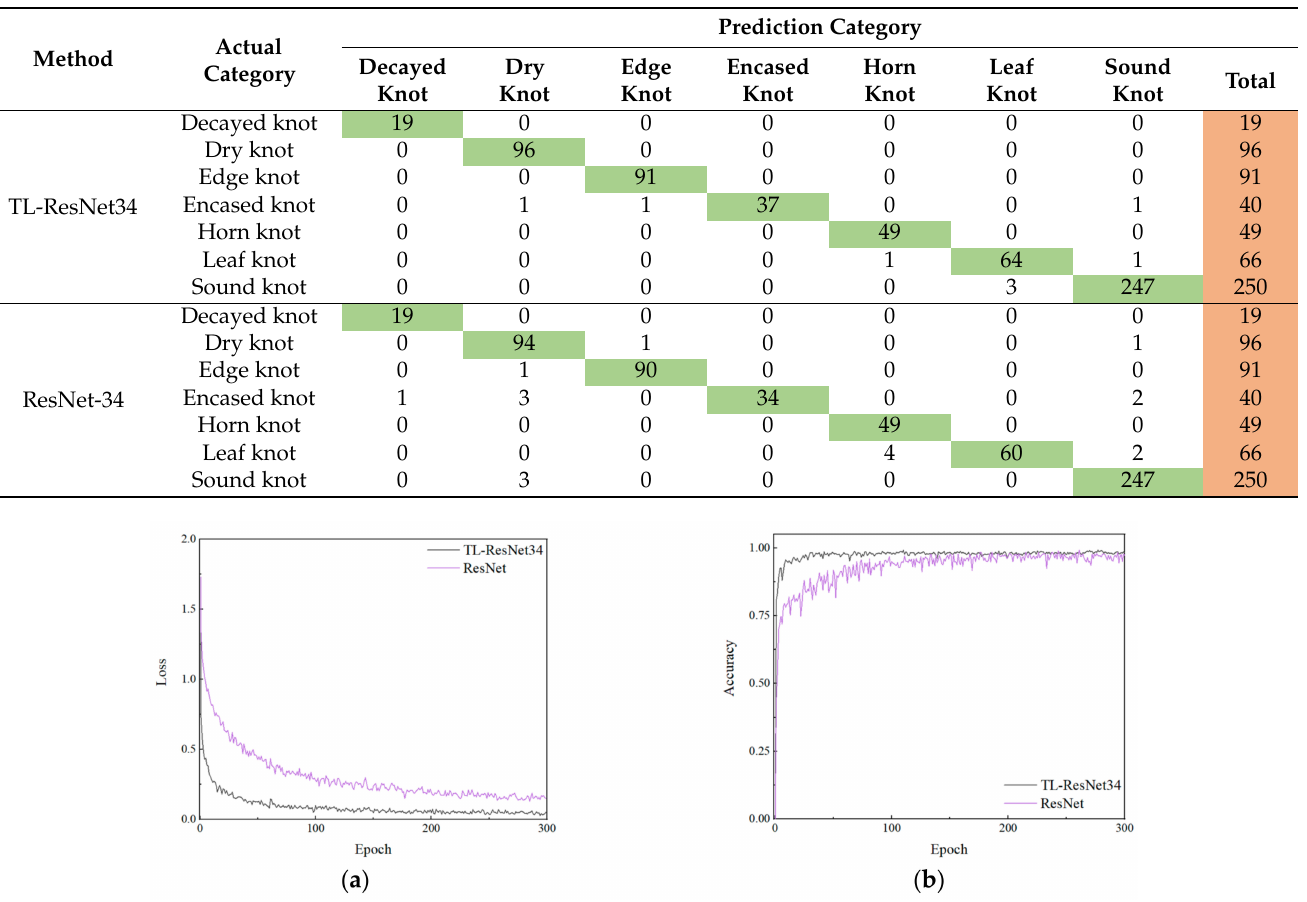
Figure 8. Comparison of the accuracy and loss of the networks with and without transfer learning: ( a ) Loss value; ( b ) Accuracy value.